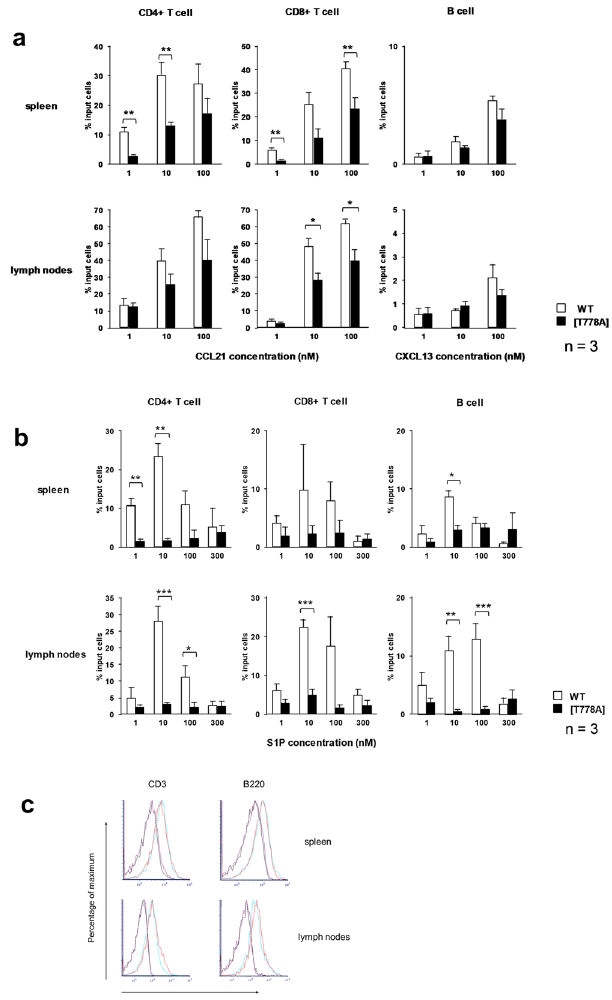
Figure 7. Chemotaxis of lymphocytes in vitro . Migration of CD4 ( + ) T cells, CD8 ( + ) T cells, and B cells from the spleens and lymph nodes of WT (open bars) and PKN1[T778A] (closed bars) mice toward the indicated chemokines ( a ) and S1P ( b ) was examined using a Transwell chamber. Data were analysed with unpaired t - tests. * P < 0.05. ** P < 0.01. *** P < 0.001. ( c ) Flow cytometric analysis of the surface expression of S1PR1 on T and B lymphocytes isolated from the spleen and lymph nodes. S1PR1 expression profiles were determined after gating cells based on CD3 or B220/CD45R expression patterns. The profiles shown in black (WT) and violet (PKN1[T778A]) indicate background staining using the isotype control antibody (IgG2A)-APC, and the profiles shown in blue (WT) and red (PKN1[T778A]) indicate staining with the anti S1PR1